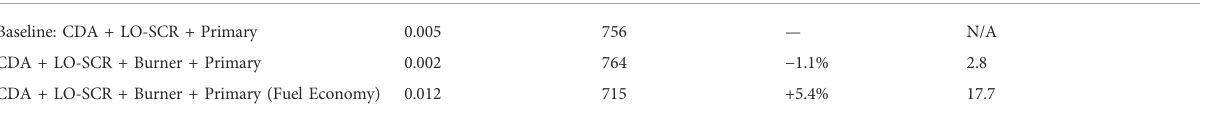
TABLE 10 BEV results comparison between Baseline and CDA + LO-SCR + Burner + Primary system. The table also includes a point with a fuel economy engine